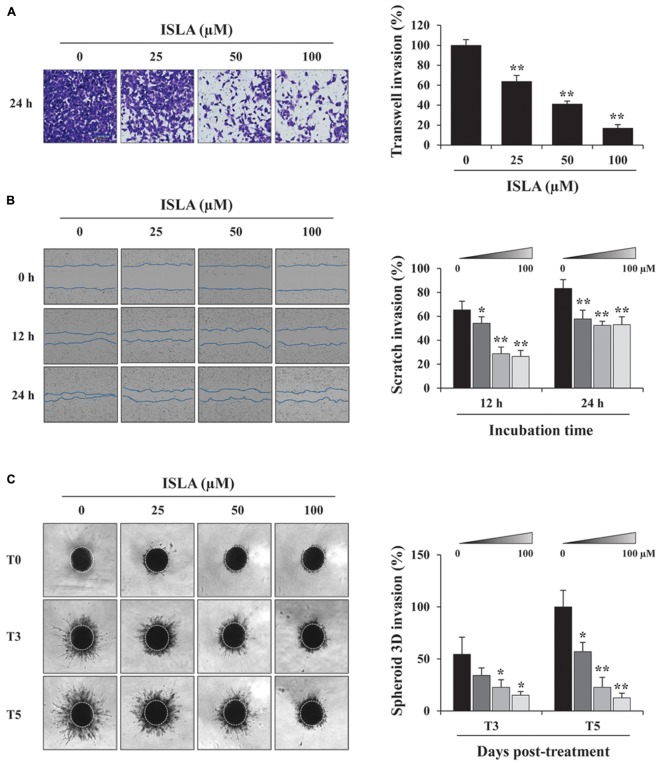
Isoliquiritin apioside suppressed the invasion of HT1080 cells. (A) HT1080 cells were pretreated with or without ISLA for 12 h and allowed to invade across a Matrigel-coated Transwell® membrane. After 24 h, the number of invaded cells was counted using phase contrast inverted microscopy after staining with Crystal Violet solution. Relative invasion compared with untreated control cells was calculated and expressed as the mean ± SD from five random fields. Data are representative of three independent experiments. (B) A scratch-wound was made on HT1080 cell layers using a 96-pin wound maker. ISLA-containing Matrigel was added to the cells and allowed to polymerize for 30 min at 37°C. Cells were incubated in ISLA-containing medium in a 5% CO2 incubator at 37°C and monitored every 3 h using an IncuCyte Zoom. The relative wound invasion in each group at 12 and 24 h was calculated based on the wound width at 0 h, using ImageJ software, and expressed as the mean ± SD from triplicate experiments. (C) Cells assembled to compact spheroids were incubated in the presence or absence of ISLA for 5 days. The images of stellate-like spheroids were photographed at 3 and 5 days post-treatment (T3 and T5), and the reactive spheroid area was determined using ImageJ software. The data are expressed as means ± SD from triplicate samples. ∗p < 0.05, ∗∗p < 0.01 vs. ISLA-untreated control.